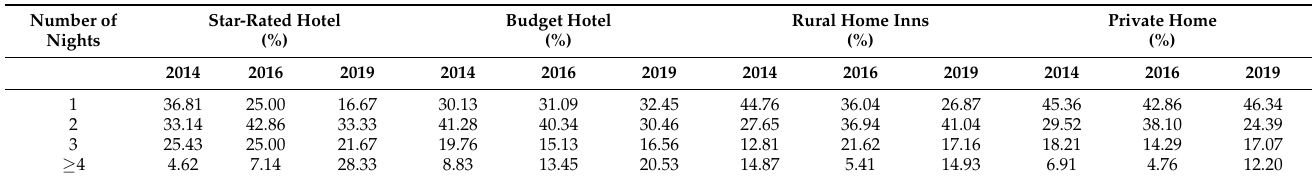
Table 2. Percentage (%) of stays at different types of accommodation in the survey